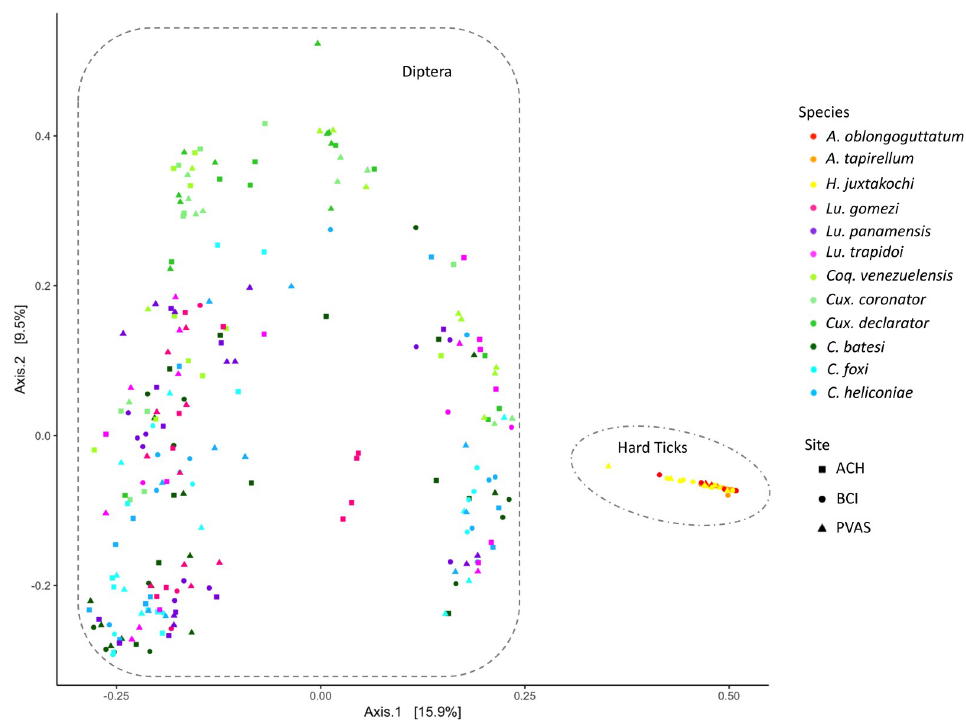
Fig 2. PCoA ordination analysis based on UNIFRAC distances with 16S gene sequence variation of the bacterial communities from six blood-feeding arthropod genera.